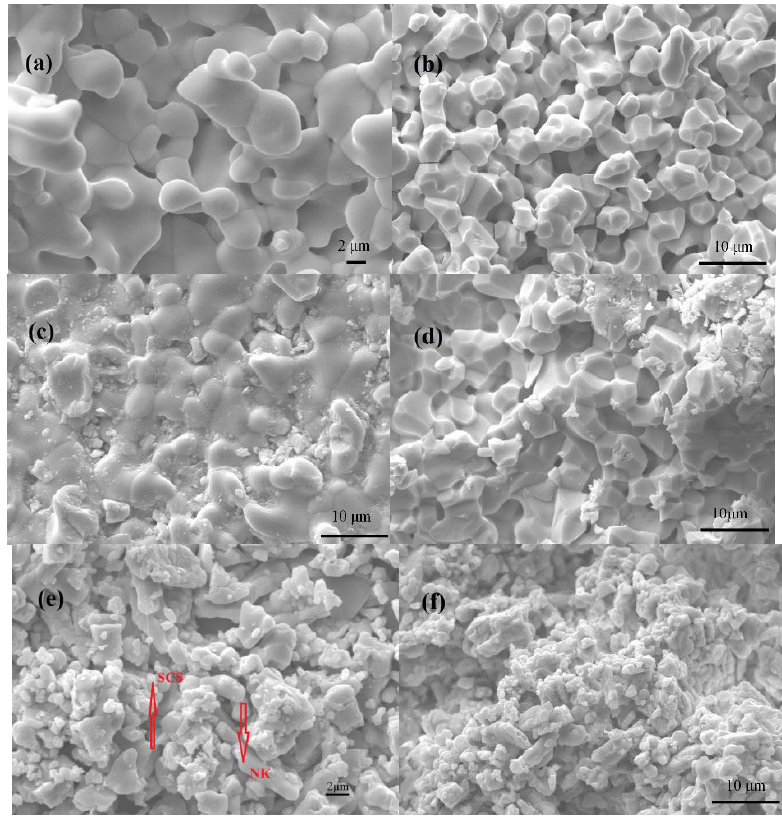
Figure 2. Surface ( a , c , e ) and cross-sectional ( b , d , f ) SEM images of SrCeO 3 (SC), SrCe 0.9 Sm 0.1 O 3-α (SCS) and SrCe 0.9 Sm 0.1 O 3-α -NaCl-KCl (SCS-NK) pellets.